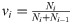
Distribution of the generation times to second mutation, obtained from stochastic simulations, in the case where v depends on the compartment sizes.We perform 5000 stochastic simulations and compare two arrangements of the compartment sizes: (a) constant compartment size (red bars) and increasing (blue bars); (b) decreasing (red bars) and increasing (blue bars). Compartment sizes are as in Fig 6. The self-renewal probabilities are v1 = 1, v3 = 0, vi=NiNi+Ni-1, i = 1, 2. We assume n = 3 and u = 0.001. In part (a), the mean time to a two-hit mutant for constant and increasing architecture is 3.65 and 3.59 respectively; the p value obtained by a two-tailed t-test is p ≪ 0.001, the effect size is 0.12. In part (b), the mean time to a two-hit mutant for decreasing architecture is 3.73; p ≪ 0.001; the effect size is 0.30.